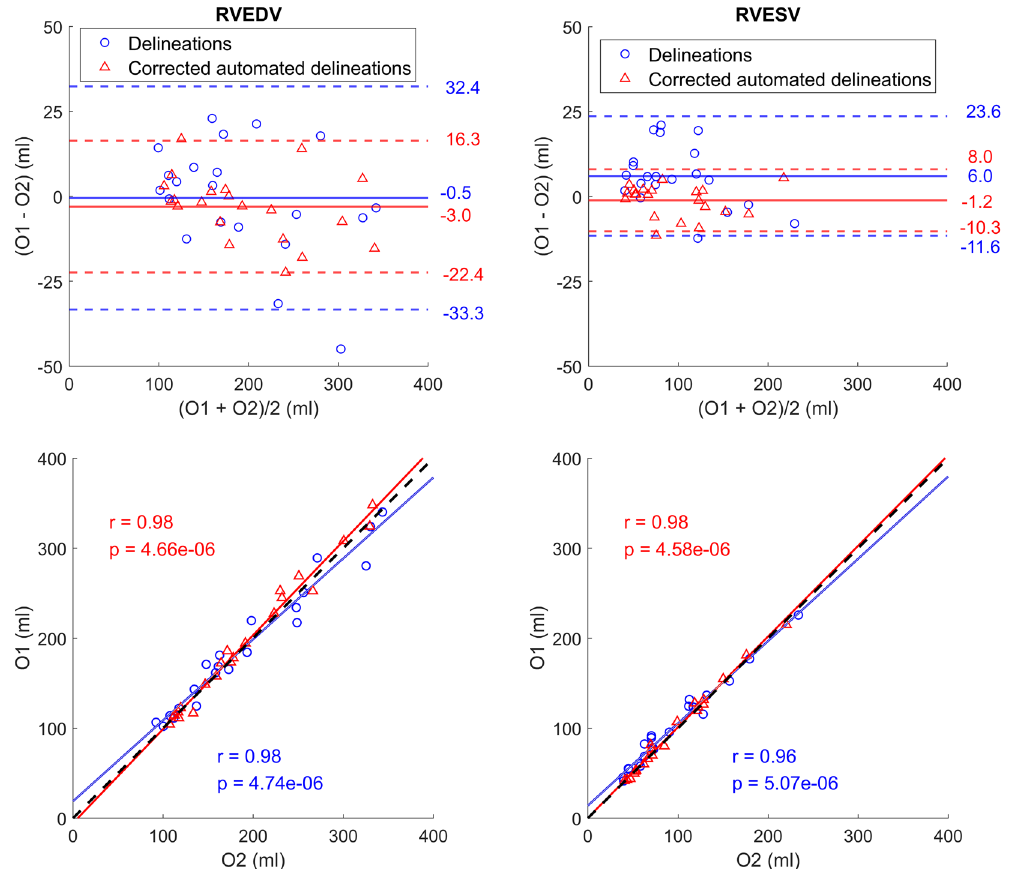
Figure 5. Bland–Altman plots and correlation plots showing the inter-observer variability for manual delineations (blue) and the corrections of delineations from the pipeline (red). To the left are results for end- diastolic volumes (RVEDV) and to the right are results for end-systolic volumes (RVESV). The Bland–Altman plots contain bias (full lines) and limits of agreement (± 1.96 SD, dashed lines). The correlation plots contain identity lines (black, dashed lines), least squares lines (full lines), Spearman’s rank correlation coefficients (r) and corresponding p values. Both plots indicate that the inter-observer variability decreased when the pipeline was used, and delineations were